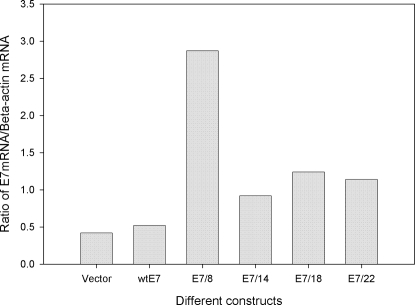
Northern blot analysis of cells transiently transfected with E7 expression constructs.RNA from transiently transfected cells was blotted to Hybond N+ membrane and probed for E7 message using a mixture of all E7 genes for the probe. Message was standardized to beta actin control. Elevated E7 RNA signals were obtained for all codon-modified genes; E7/8 gave the highest signal.